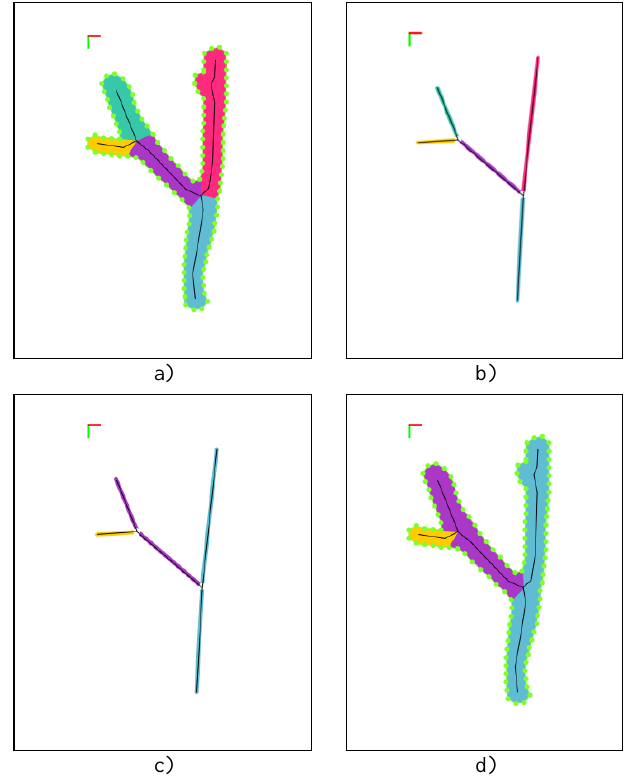
Figure 8. Retrieval of paths. a) Component after point assignment and determination of paths between irregular vertices. b) Temporary graph; paths are contracted to edges. c) Result of path retrieval on contracted graph. d) Updated partition according to determined